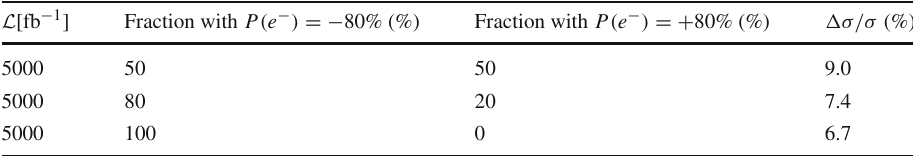
Table 6 Dependence of the cross-section measurement for HH ν ¯ ν at 3TeV on the distribution of the luminosity between the two beam polarisation states of the electron beam. The same polarisation factor is assumed for signal and background as explained in the text